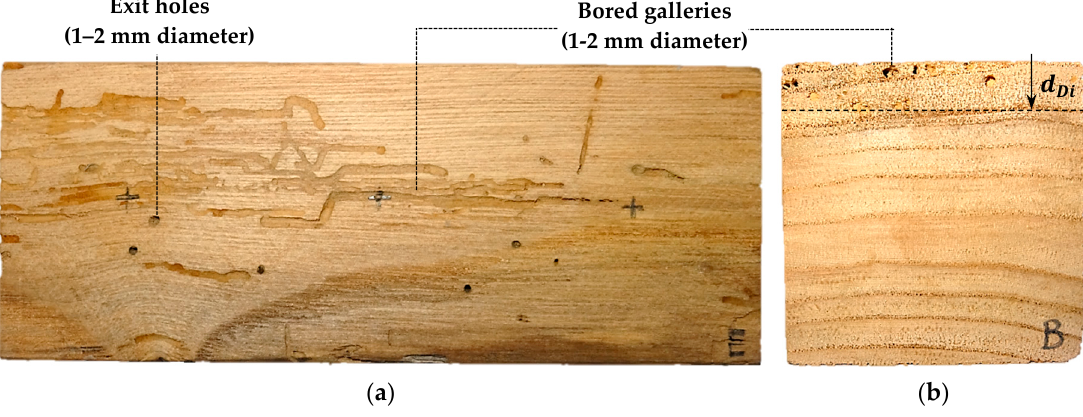
Figure 7. Upper face ( a ) and cross-section ( b ) of the insect deteriorated sample Di_1. Table 1. Density loss as per physical aspects and damage features of anobiid-deteriorated wood.